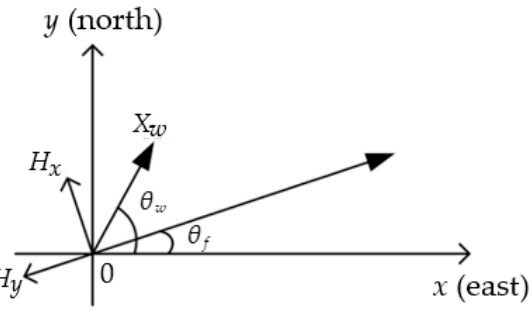
Figure 4. Schematic diagram of flight direction, wind direction, and deposition components.